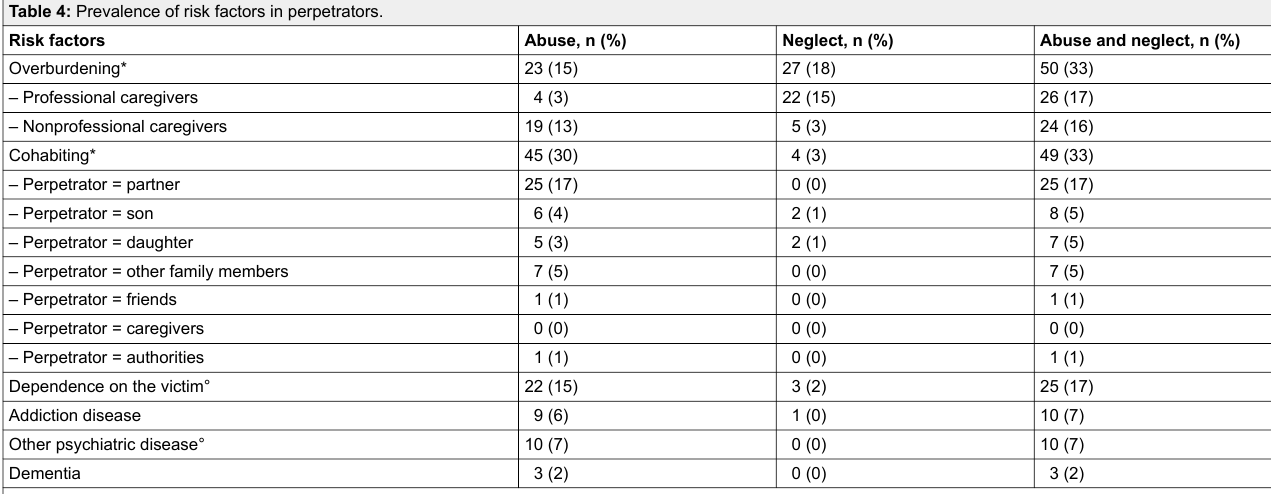
Table 4: Prevalence of risk factors in